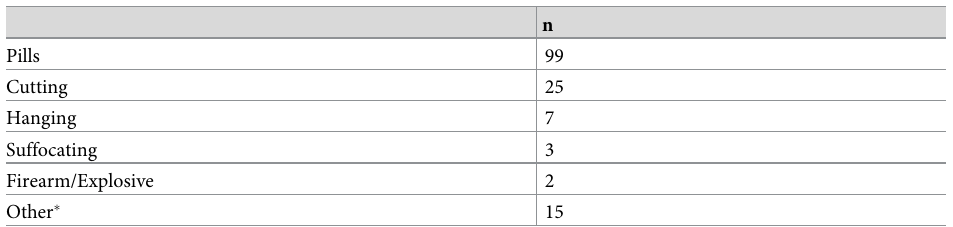
Table 3. Method of suicide